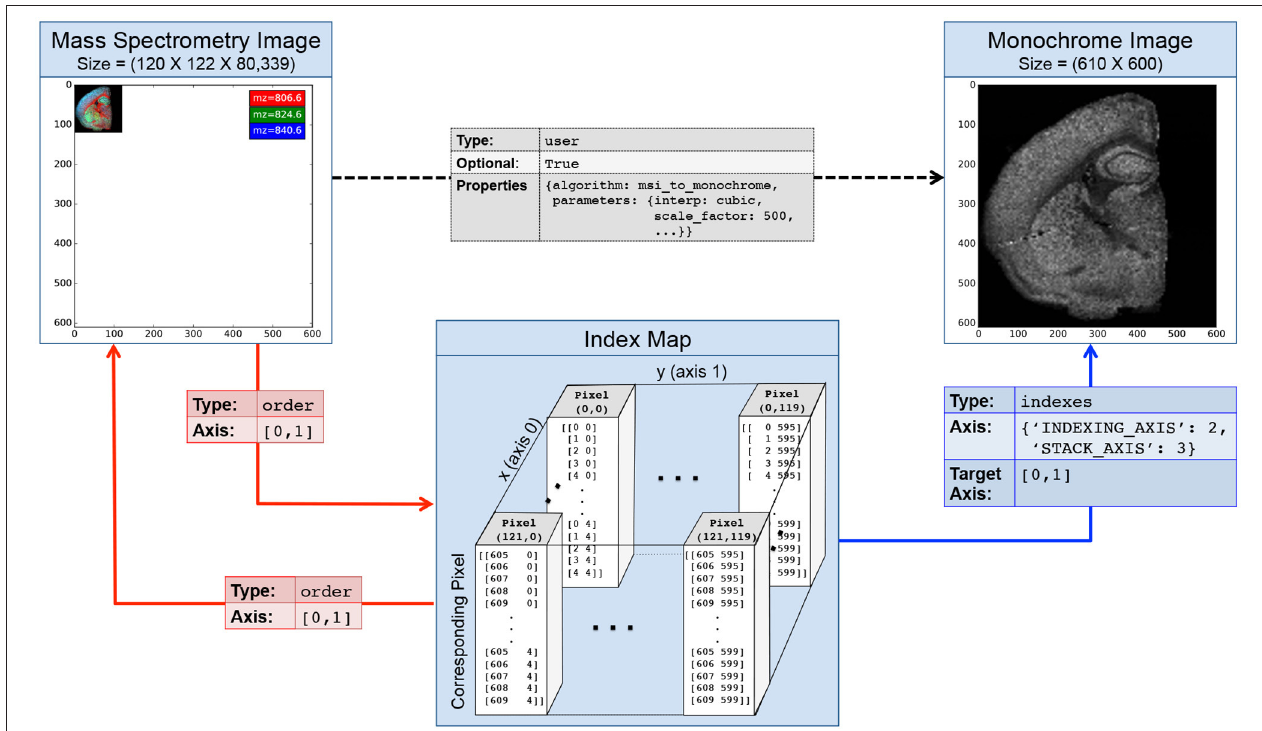
FIGURE 4 | Illustration of an index map relationship describing the interaction between a mass spectrometry image (MSI) and a derived monochrome image. The MSI image is in this case 5 × smaller than the monochrome image. The intermediary index map describes for each pixel in the MSI image which pixels it corresponds to in the the monochrome image. Two order relationships (red arrows) describe the interactions between the MSI image and the map and vice versa . A third indexes relationship links our index map to the monochrome image and describes how the map can be used to access the image. Optionally, we may create a fourth user relationship (black arrow) to further characterize the semantic relationship between the derived and original image (e.g., to store a description of the algorithm and parameters used to generate the image). Naturally, we can also describe the inverse mapping between the original and processed image via a second index map relationship.